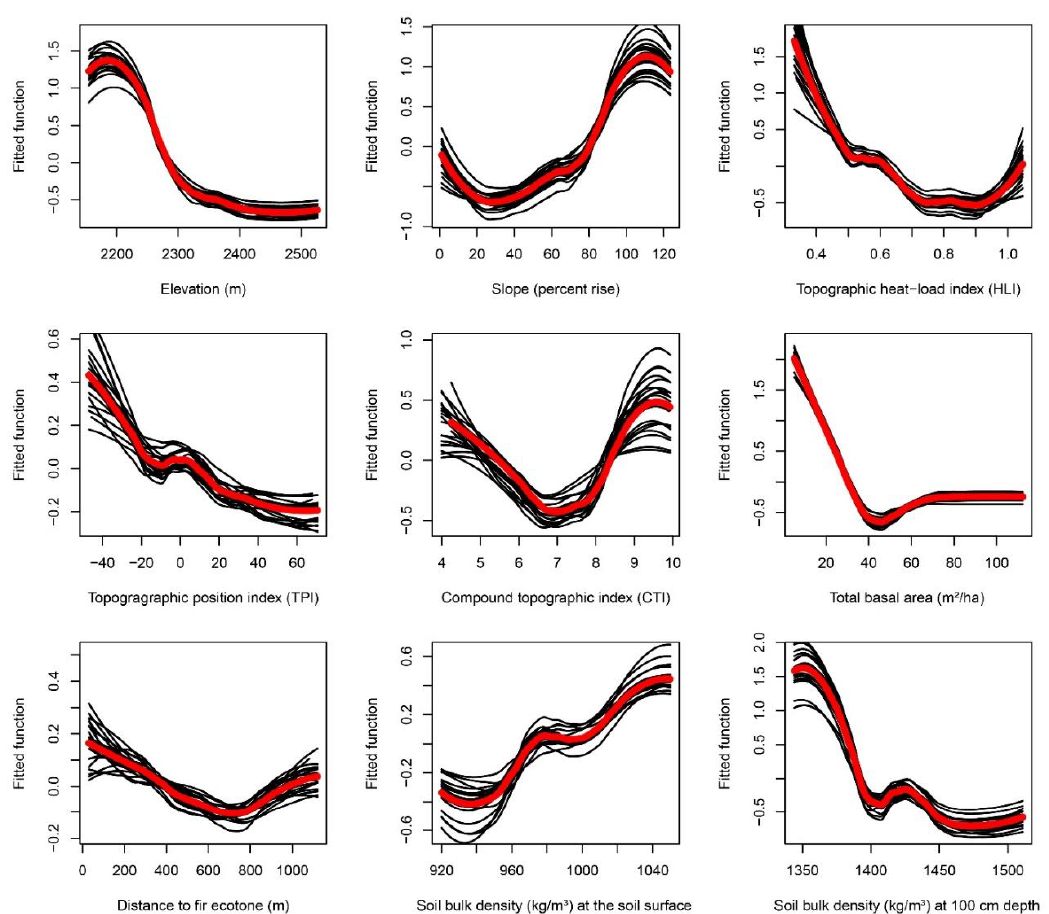
Figure A6. Partial-dependence plots from boosted regression tree models of refugia from drought and mountain pine beetle impacts in lodgepole–whitebark pine areas in 2009. Black lines represent loess-smoothed partial-dependence relationships from 20 independent bootstrapped model runs using a random subsample of n = 2000 grid cells for each model run. Red lines indicate means across 20 bootstrapped model runs. In all plots, higher values on the vertical axis represent greater prevalence of refugia.